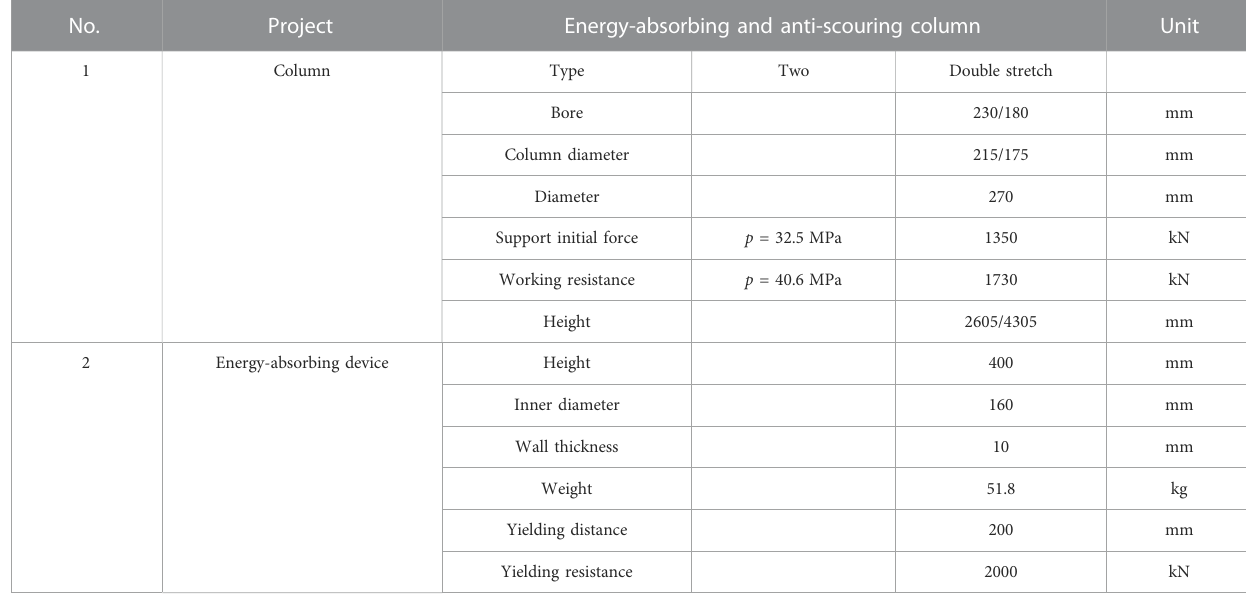
TABLE 1 Parameters of the energy-absorbing and anti-scouring column. No. Project Energy-absorbing and anti-scouring column Unit